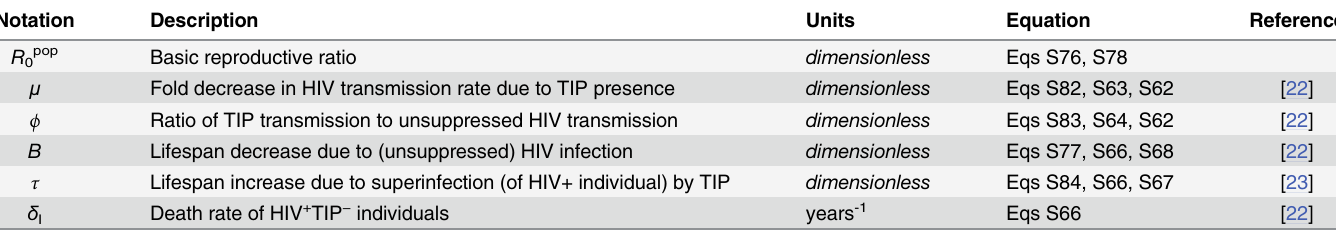
Table 1. Population-level parameters *